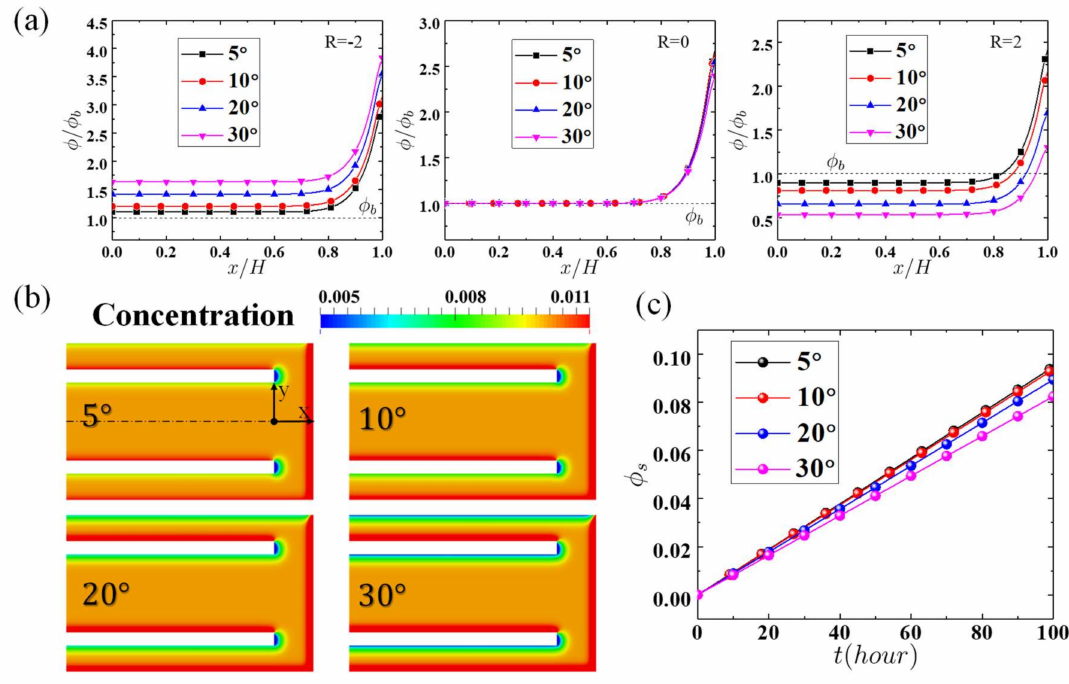
Figure 7. ( a ) Nanoparticle profiles along the X-direction at R = − 2 (left), R = 0 (middle), and R = 2 (right) for different angles of inclination after 100 h of simulation. ( b ) Nanoparticle concentration field (x-y slice) for different angles of inclination after 100 h of simulation. ( c ) Nanoparticle accumulation ( φ s ) as a function of time with different